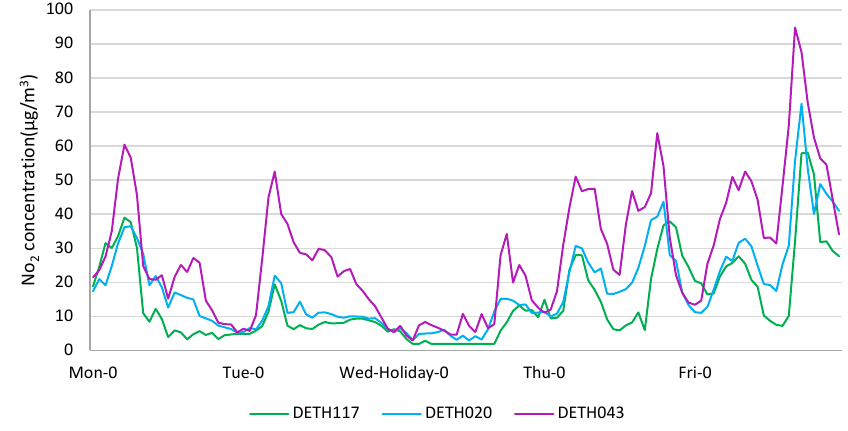
Figure 8. NO 2 concentration for three sensors, from October 1 until 5 October 2018.